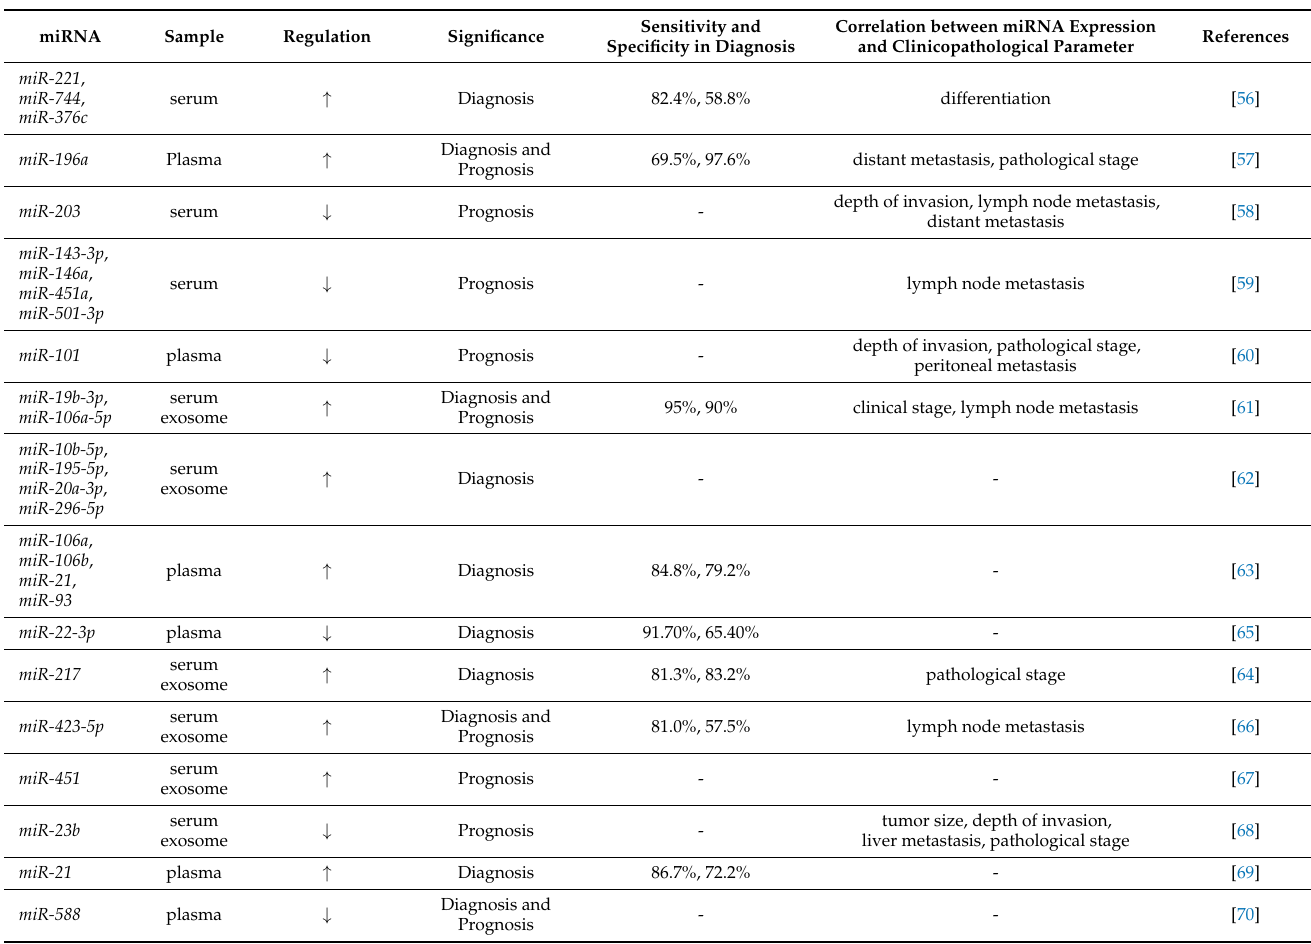
Table 2. Gastric